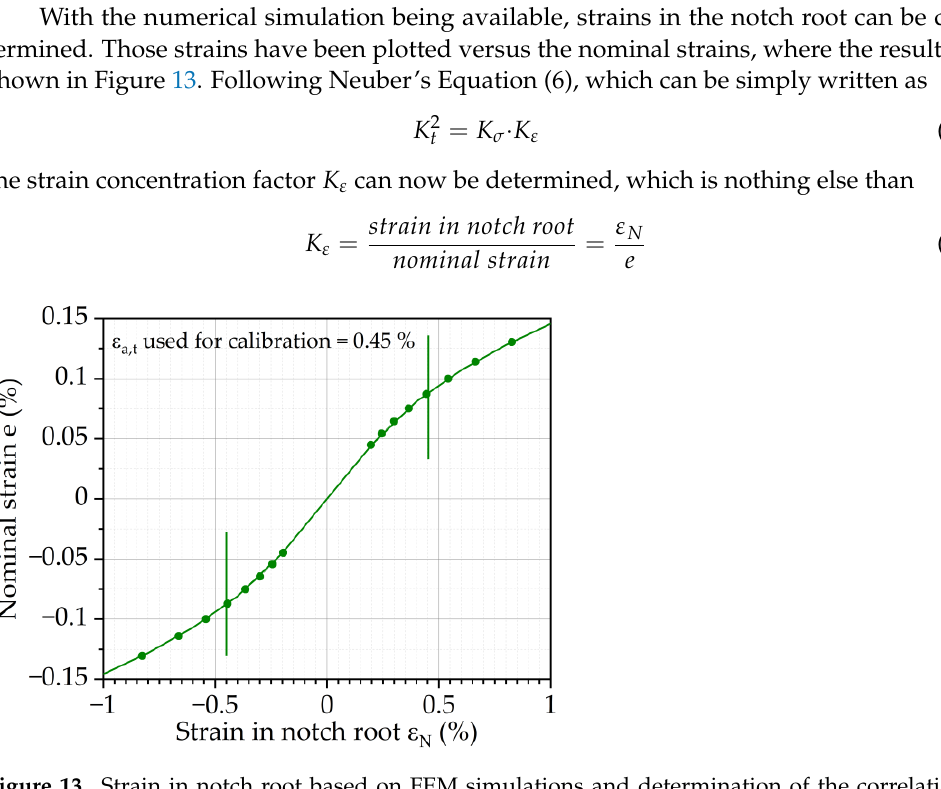
Figure 13. Strain in notch root based on FEM simulations and determination of the correlation between measured nominal strain values and strain in notch for specimens with R N = 0.35 mm.